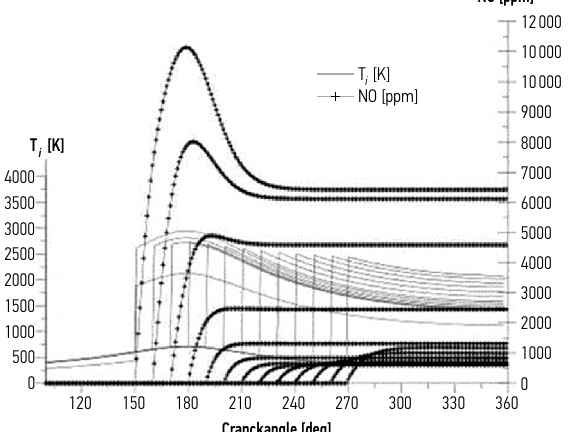
Fig. 5. The temperature and NO concentration of the zones as a function of the crank angle and NO emissions of the zones ( source : own calculations)